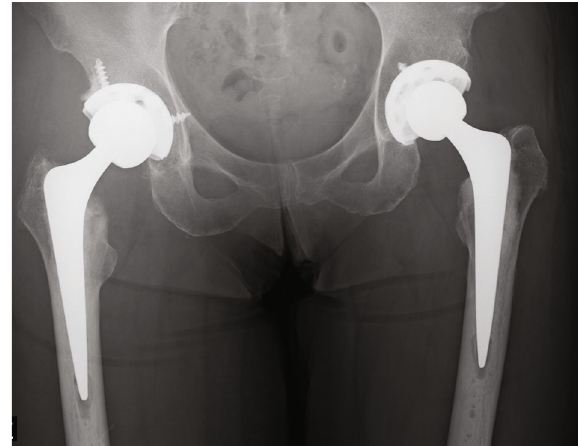
Figure 3: Postoperative plain radiograph. Hybrid THA was performed on both